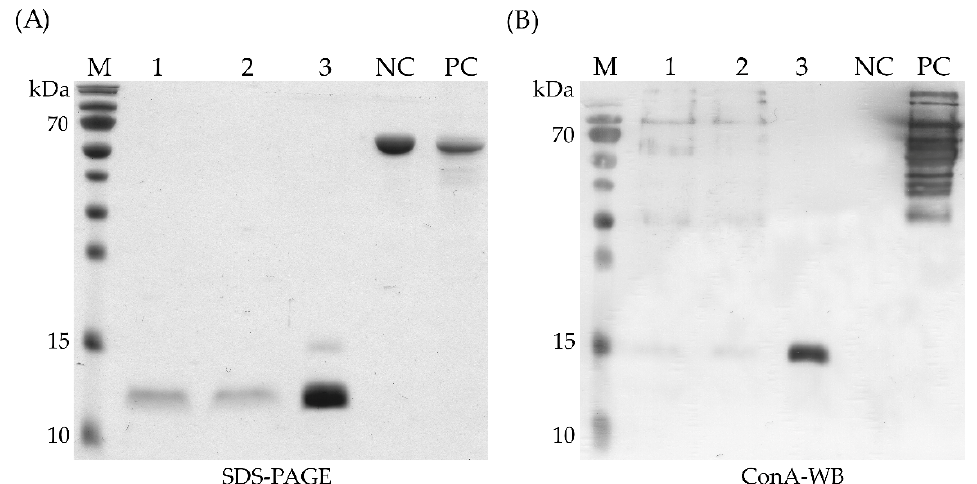
Figure 4. Determination of N -glycosylation of YqfB after expression in P. pastoris cells. ( A ) Protein profiles in SDS-PAGE and ( B ) Western Blot analysis with ConA. 1–3—protein samples prior to (1) and after (2) dialysis of yeast growth media and purification by affinity chromatography (3). PC— P. pastoris -produced glycosylated black tiger shrimp protein, Pen m 4, fused to the Maltose-binding protein (MBP), acts as a positive control for Western blot analysis with ConA. NC— E. coli -produced Pen m 4 protein fused to MBP acts as a negative control.